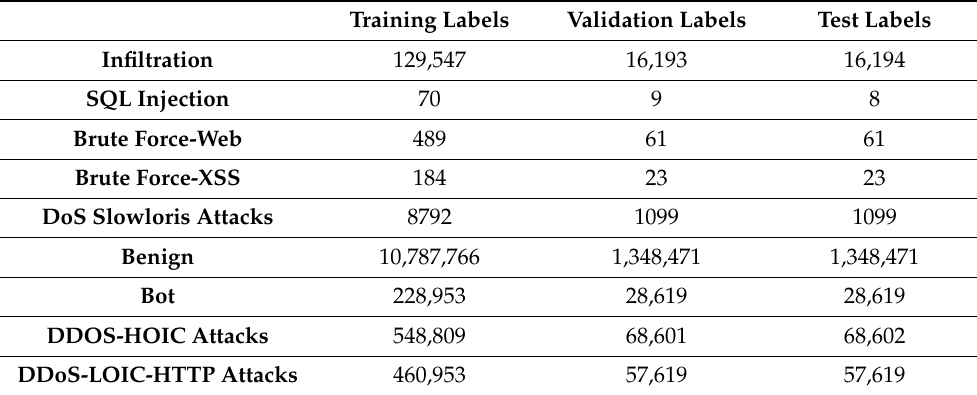
Table 4. Distribution of 9 different types of traffic